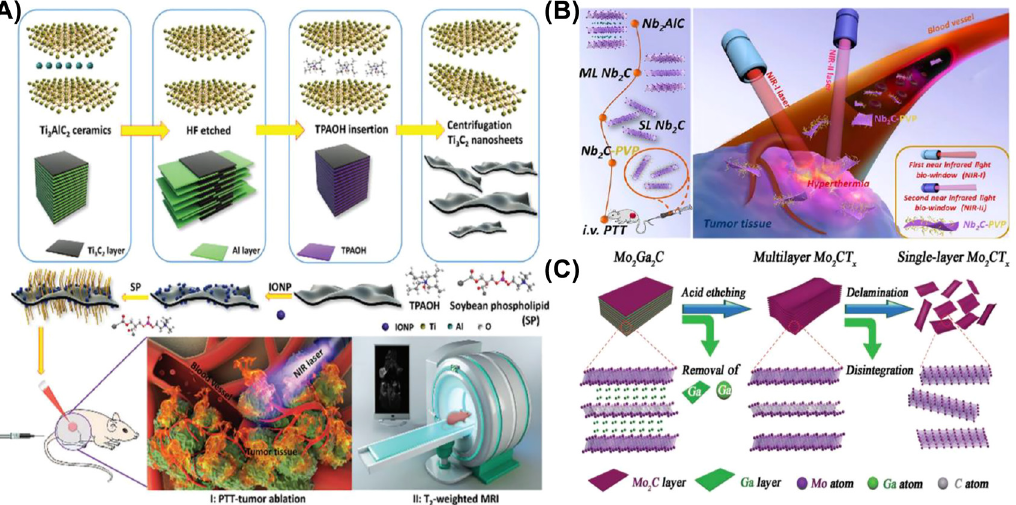
C -IONPs-SPs 3 2